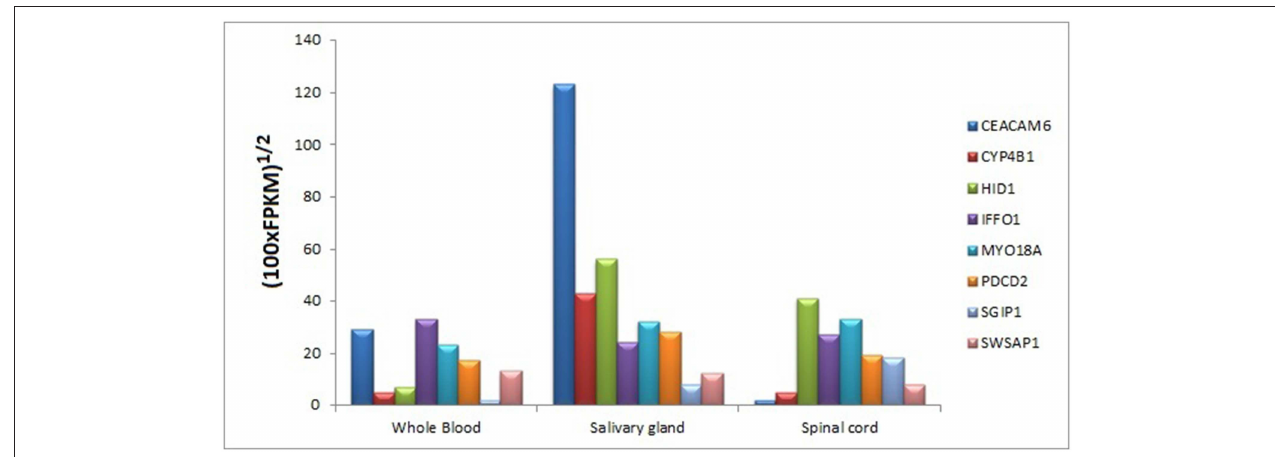
FIGURE 10 | Tissue-specific expressions of core module